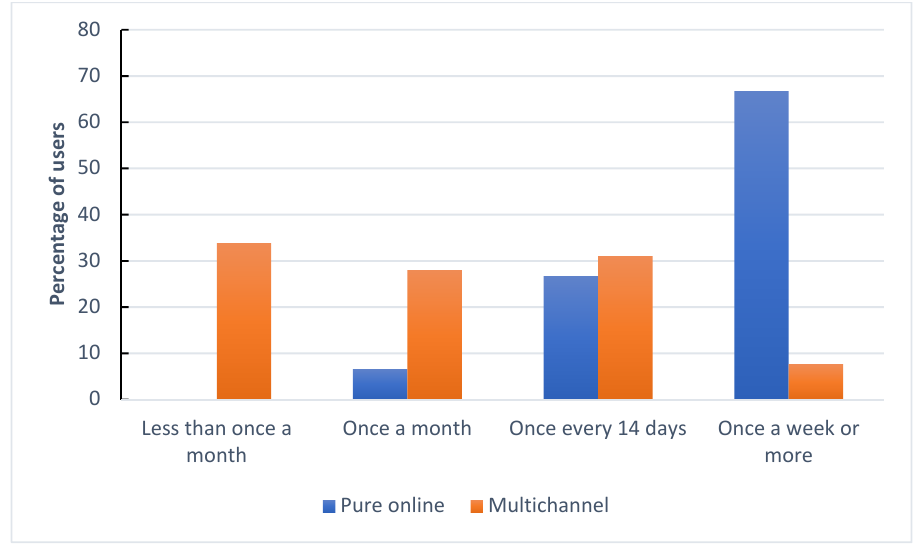
Figure 6. Multichannel vs. order frequency.